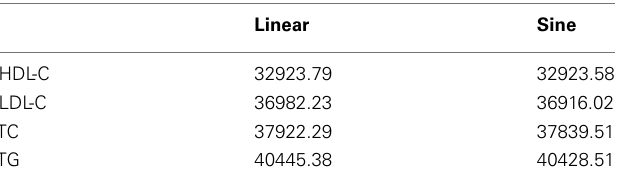
Table 4 | Model fit statistics (AIC) using age as a linear term and the sine function, f (age i ) in a non-genetic